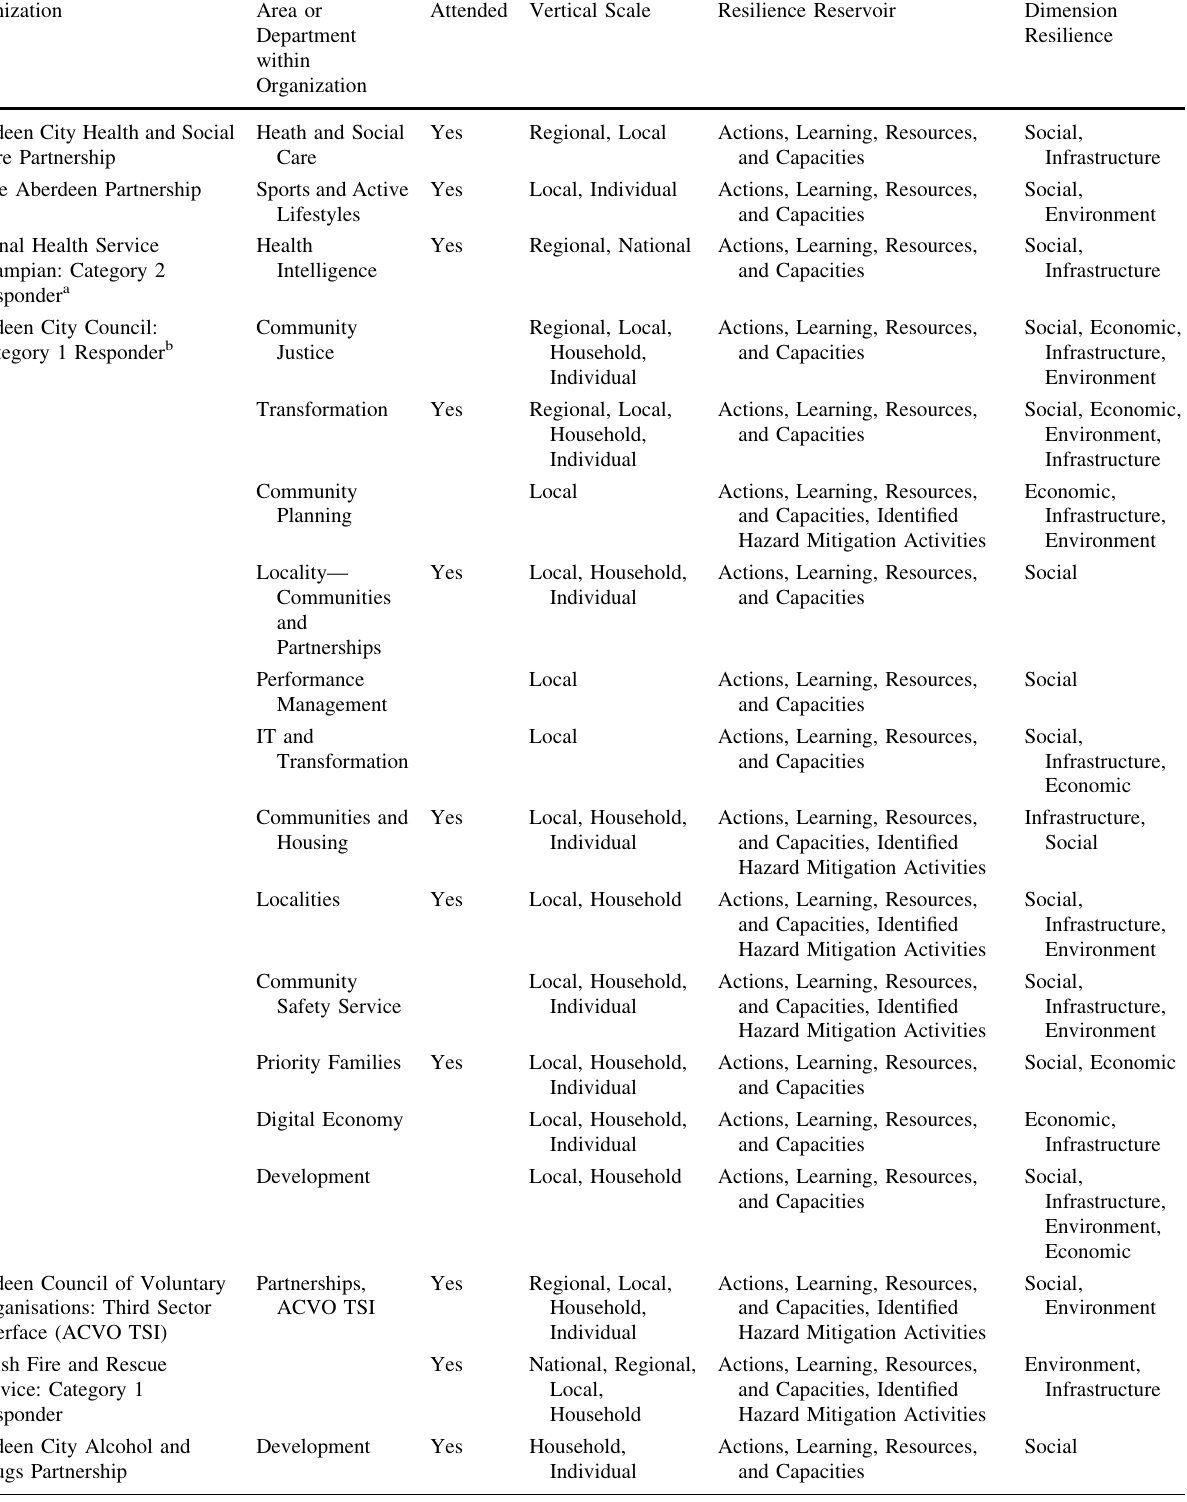
Table 2 Composition, vertical and horizontal reach, reservoirs of interest, and dimensions of interests of the Aberdeen LRPG members in January 2018, and whether they attended the January 2018 workshop at Aberdeen Health